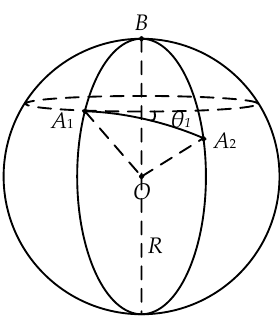
Figure 10. Example of the spherical distance-calculation method.